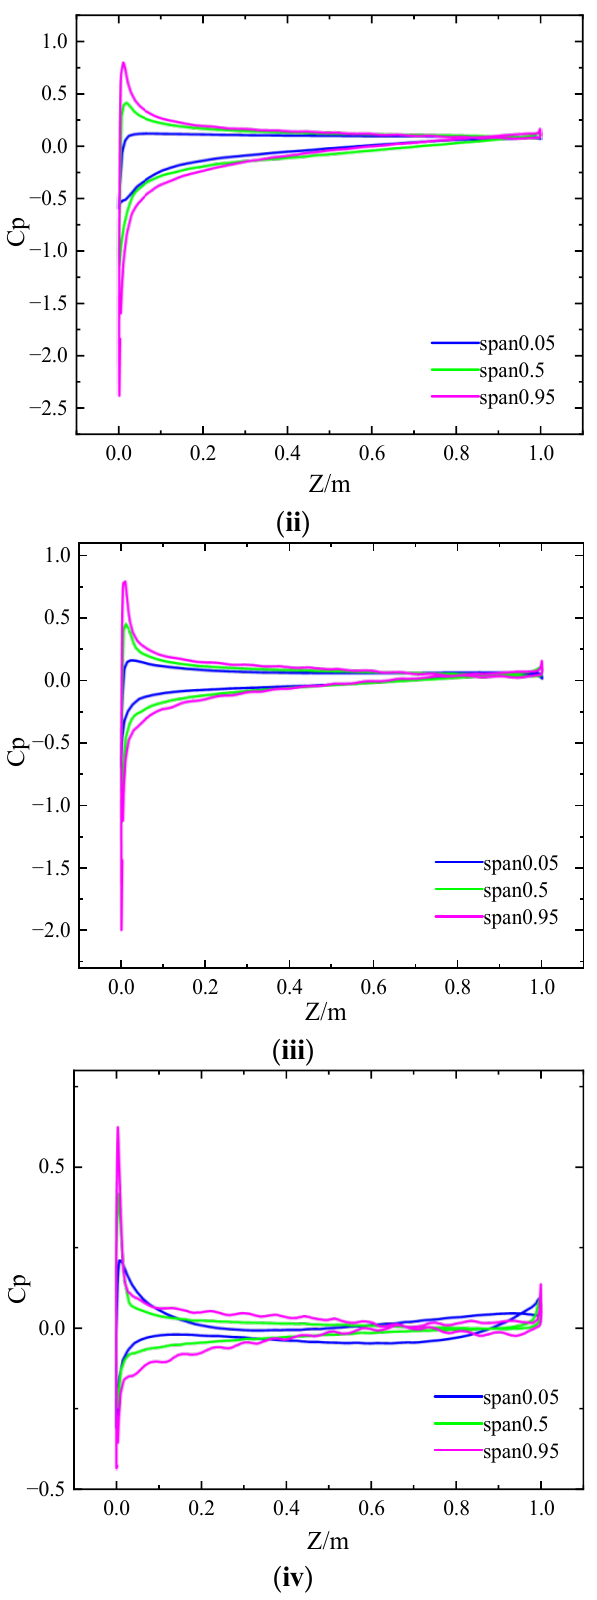
Figure 14 . Pressure coefficient diagram under pump conditions. ( i ) 0.6Q. ( ii ) 0.8Q. ( iii ) 1.0Q. ( iv ) 1.2Q.